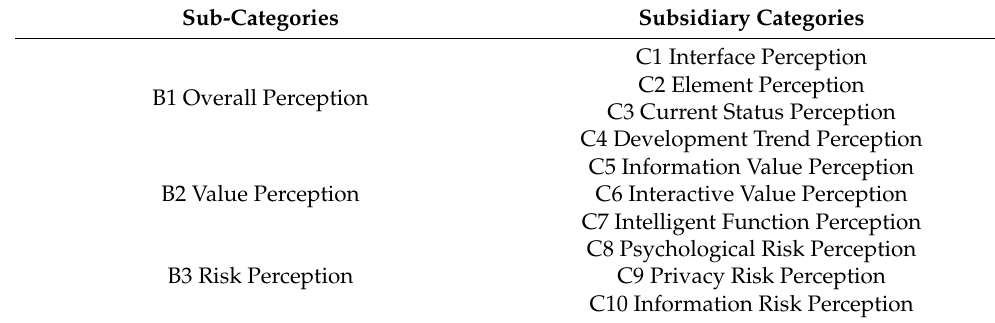
Table 6. Results of the main axis coding for 10